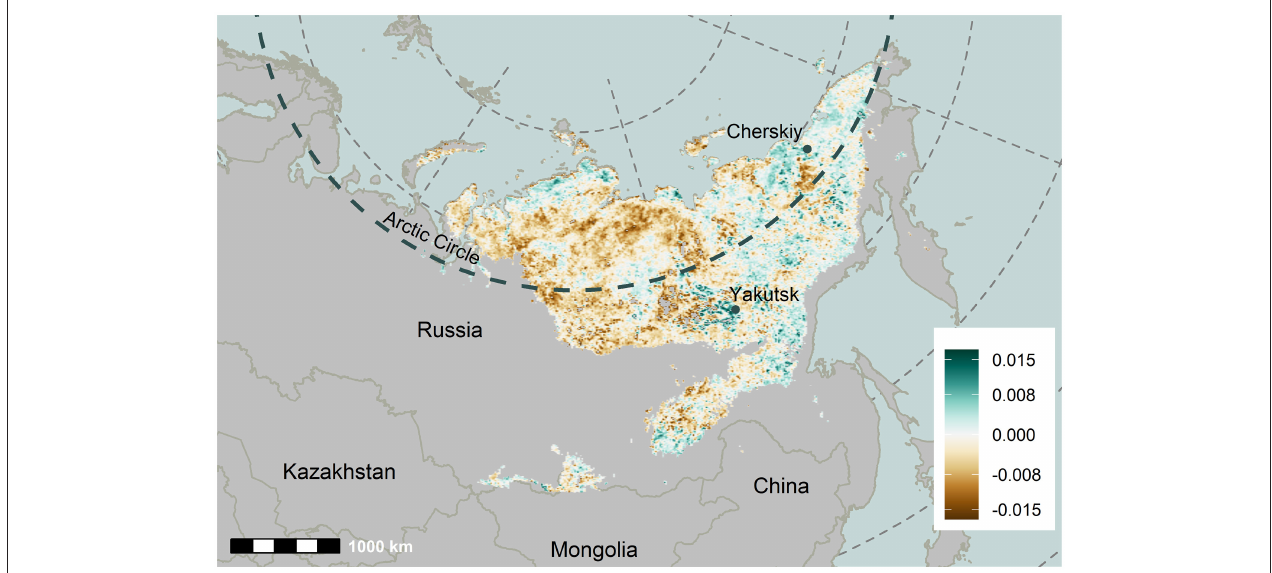
FIGURE 2 | Trends in albedo change (April–September of 2000-2019) attributed to surface water change derived using MODIS data. The standard MODIS albedo product was used to characterize albedo trends using linear regression, and the surface water change was quantified using the Superfine Water Index calculated from MODIS data. A generalized additive model (GAM) was used to attribute albedo trends to surface water change. Adapted from Webb et al.